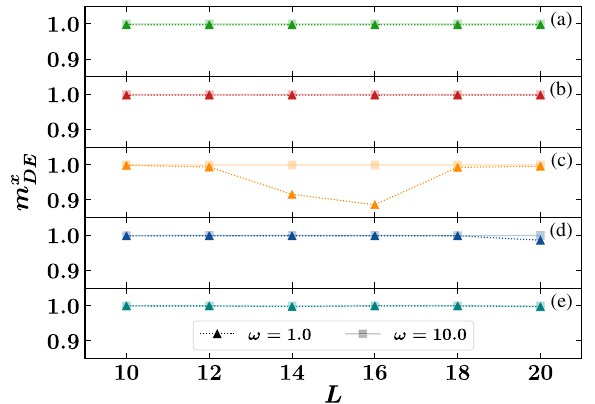
FIG. 8. L dependence of m x at the freezing peaks correspond- DE ing to h x D ¼ 40 and for ω ¼ 1 . 0 and 10.0, plotted against the system size L for different variants of the drive Hamiltonian H ð t Þ [Eq. (6)]. Panels (a) – (c) show different variants of Ising inter- actions: (a) H x 0 contains the nearest- and next-nearest-neighbor x ð 3 Spin Þ interactions and on-site fields [Figs. 1(a)]. (b) H x 0 ¼ H 0 x ð LR Þ [three-spin interactions; Fig. 6(a)]. (c) H x 0 ¼ H 0 [additional long-range interactions; Fig. 6(b)]. Panels (d) and (e) show Heisenberg interactions: H ð t Þ ¼ H HB ð t Þ . Results are shown for (d) translationally invariant clean chains and for the isotropic case [Fig. 7(a)] and (e) for the anisotropic case [Fig. 7(b)].